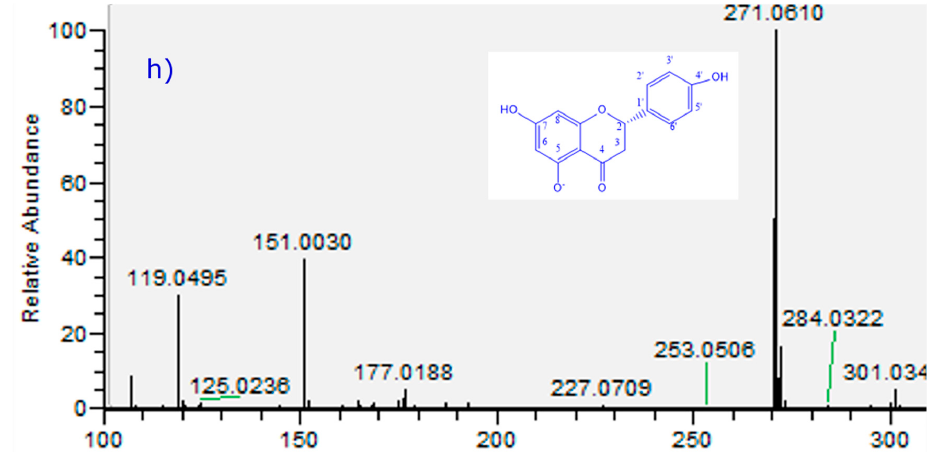
Figure 3. Full scan OT-MS n spectra of of some representative compounds identified in T. tetrandus from Chile. ( a ) Peak 4; ( b ) peak 12; ( c ) Peak 15; ( d ) peak 20; ( e ) peak 22; ( f ) peak 26; ( g ) peak 28; and ( h ) peak 35. Peaks numbers refer to those indicated in Table 2.